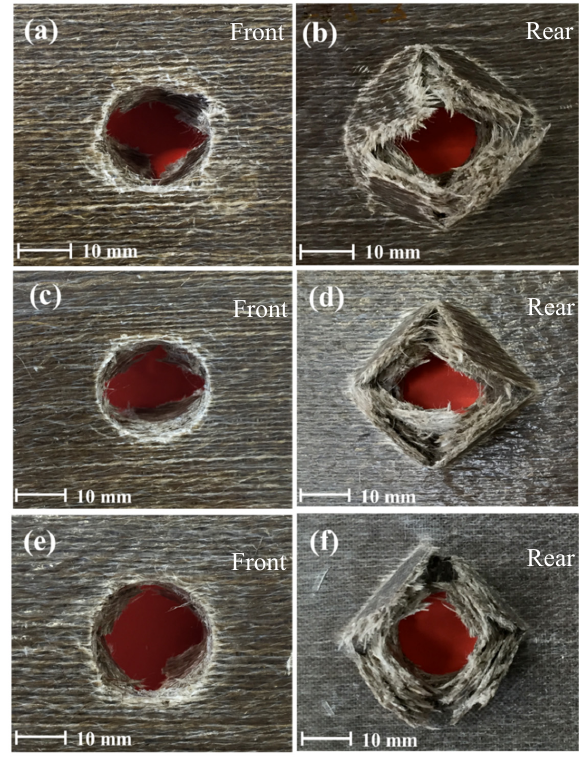
Figure 10. Images of damage progression on front and rear faces of flax/VE composite samples impacted in the range of ( a and b ) 50 J, ( c and d ) 60 J, and ( e and f ) 70 J.